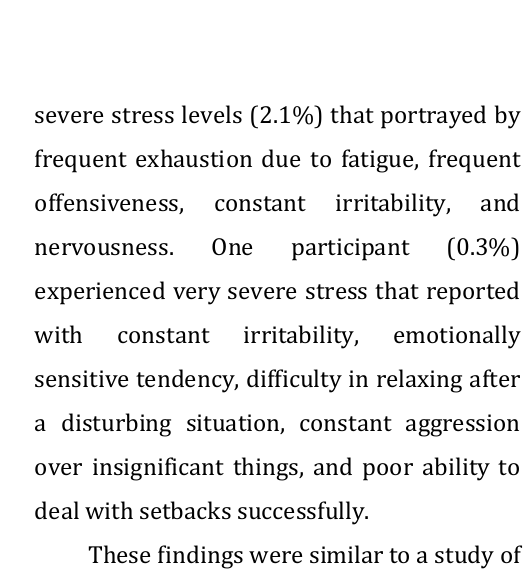
Frequency Distribution of Pecalang in Susut District, Bangli, according to the Stress Level